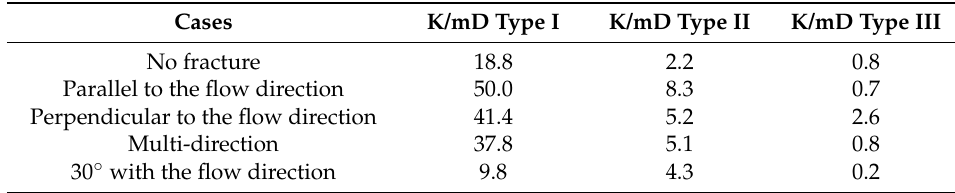
Table 3. The influence of fracture direction on the absolute permeability.